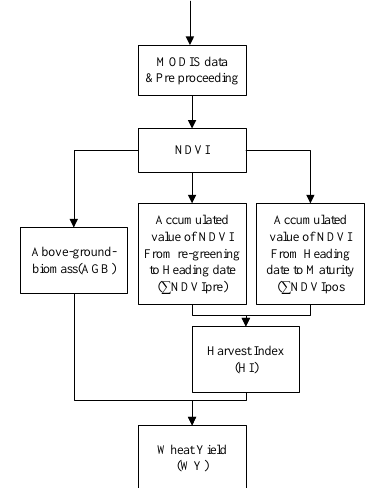
Figure 1. Flow chart of wheat yield estimation